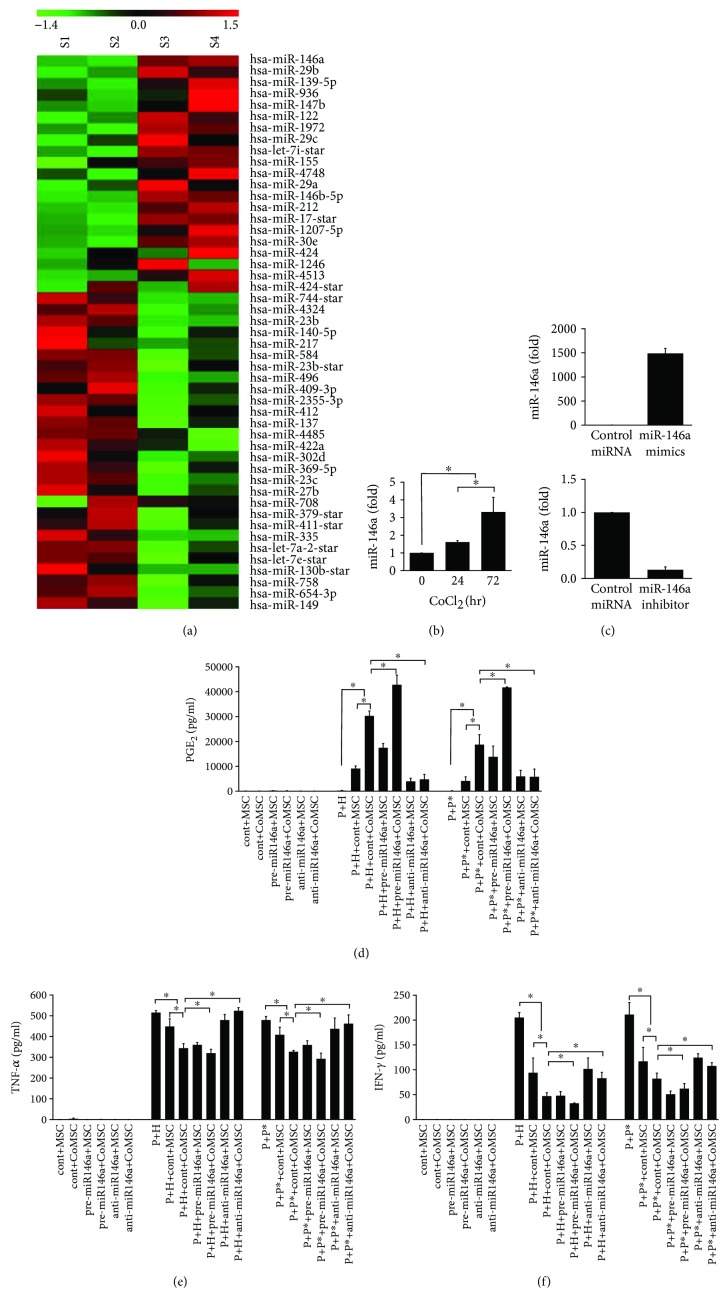
Cobalt chloride- (CoCl2-) induced expression of miR-146a in immunomodulation of hUCB-MSCs. (a) hUCB-MSCs (S1–2) and coculture of hPBMCs with hUCB-MSCs (hPBMC + hMSC, S3–4) were collected for microRNA (miR) microarray analysis. Normalized log2 miRNA expression for miRNAs that showed significant differences (p < 0.05) between groups is listed according to the color scale. (b) hUCB-MSCs were treated with 100 μM CoCl2 and then harvested at the indicated times. The expression level of miR-146a was determined by RT-qPCR. (c) hUCB-MSCs were transfected with scrambled miR-control, miR-146a mimics, or inhibitors. The expression level of miR-146a was determined by RT-qPCR. (d–f) hUCB-MSCs were transfected with scrambled miR-control, miR-146a mimics, or inhibitors and exposed to 100 μM CoCl2 for 72 h, and then allogeneic hPBMCs were cocultured with hUCB-MSCs. PGE2, TNF-α, and IFN-γ levels in the culture supernatants were measured by ELISA. Data represent the mean ± SD, n = 3; ∗
p < 0.05. P: hPBMCs; P∗: allogeneic hPBMCs as stimulator; H: phytohemagglutinin; MSC: naïve hUCB-MSCs; CoMSC: CoCl2-pretreated hUCB-MSCs.